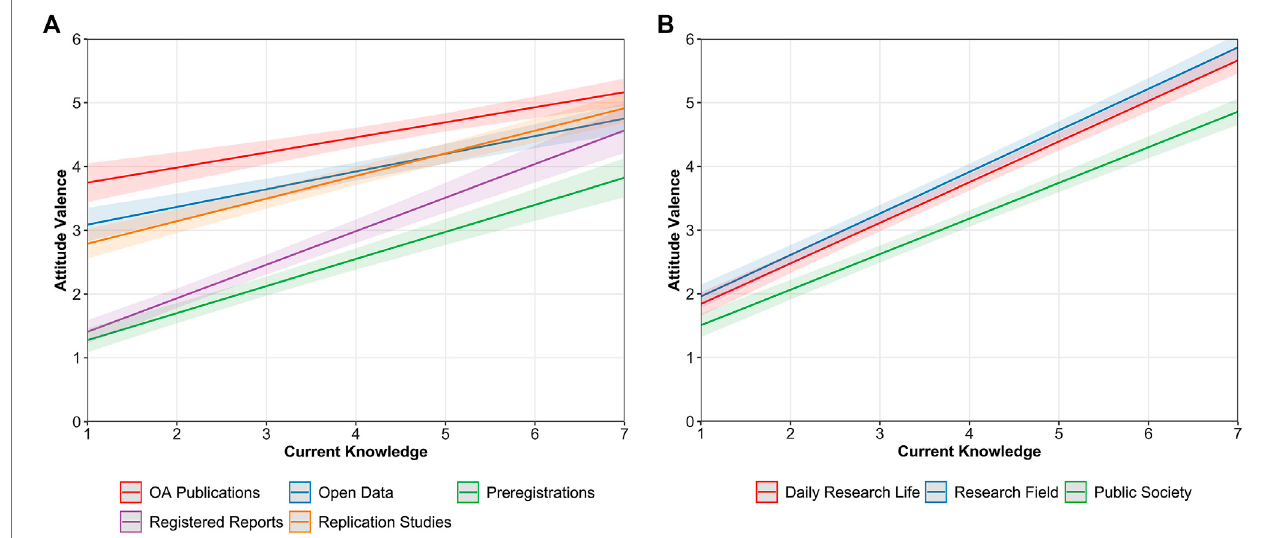
FIGURE 5 | Predicted values of attitude valence as a function of ECRs ’ current knowledge across OS practices (A) and different perspectives (B) . Bandwidths represent 95% con fi dence intervals (CIs).